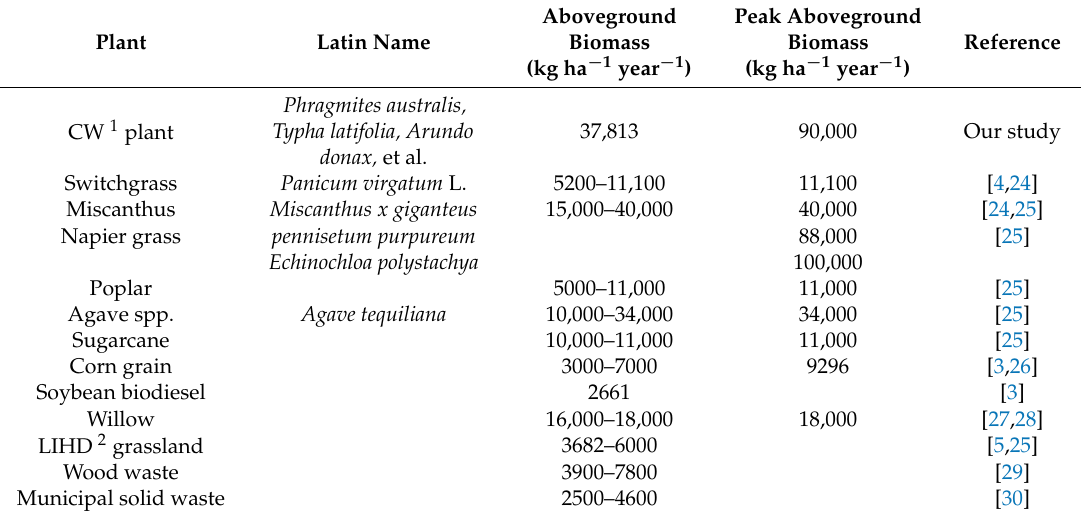
Table 1. Aboveground biomass production of current or potential biofuel plants.